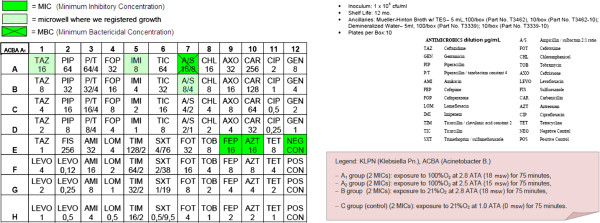
Acinetobacter baumanii (ACBA) exposed to 100% O2at 2.8 ATA.